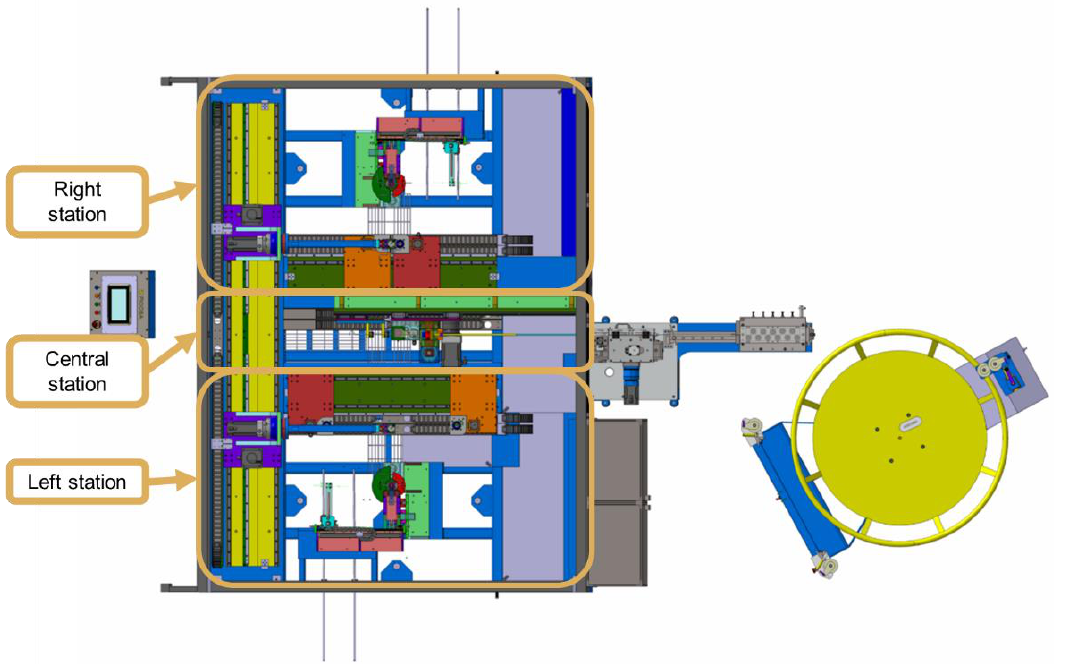
Figure 20. Wire-bending equipment, new concept.